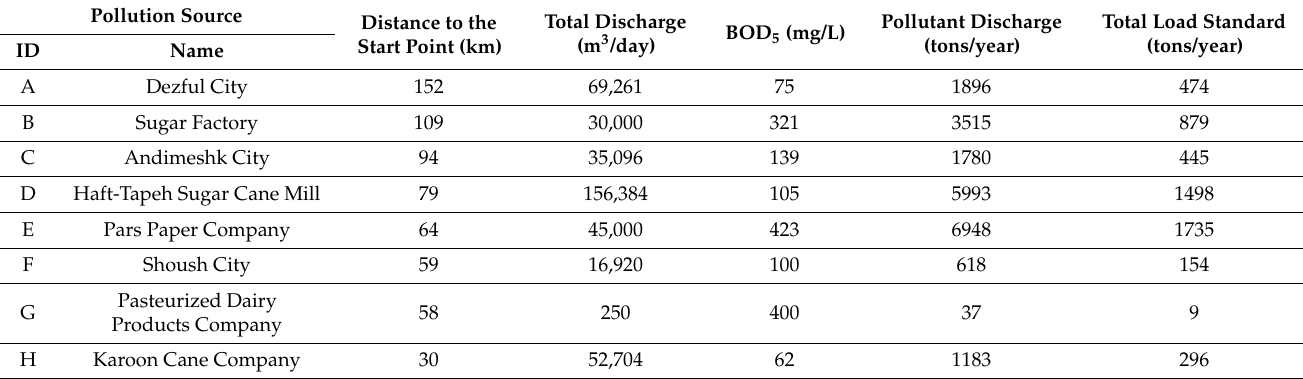
Figure 3. The schematic view of the study area. Table 1. The specification of the pollutant units in the study